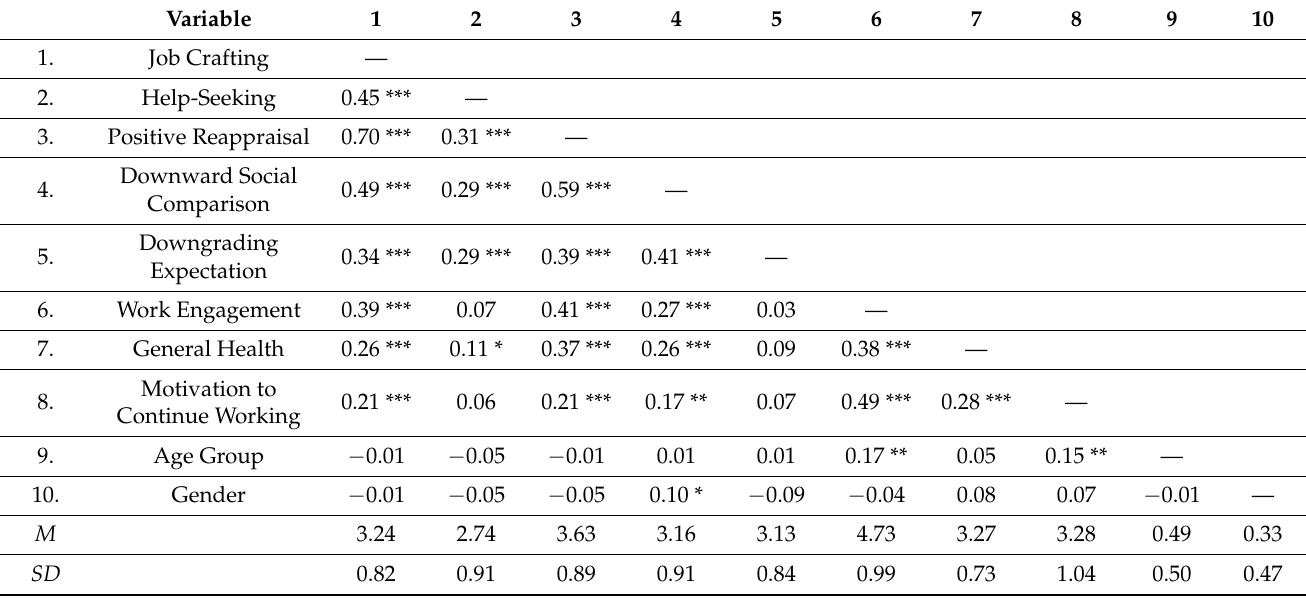
Table 3. Mean, standard deviations, and correlations among study